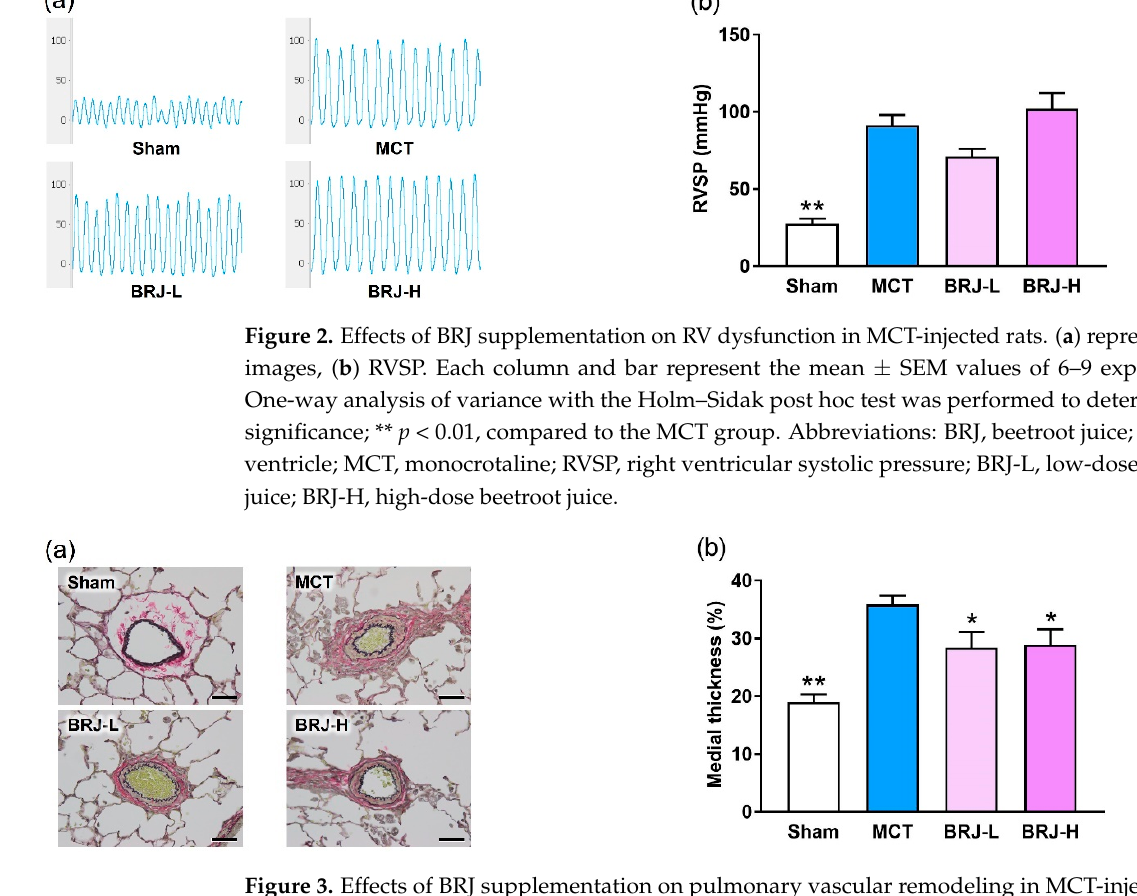
Figure 3. Effects of BRJ supplementation on pulmonary vascular remodeling in MCT-injected rats. ( a ) representative images (scale bar, 50 µm), ( b ) medial thickness. Each column and bar represent the mean ± SEM values of 6–9 experiments. One-way analysis of variance with the Holm–Sidak post hoc test was performed to determine the significance; * p < 0.05 and ** p < 0.01, compared to the MCT group. Abbreviations: BRJ, beetroot juice; MCT, monocrotaline; BRJ-L, low-dose beetroot juice; BRJ- H, high-dose beetroot juice.